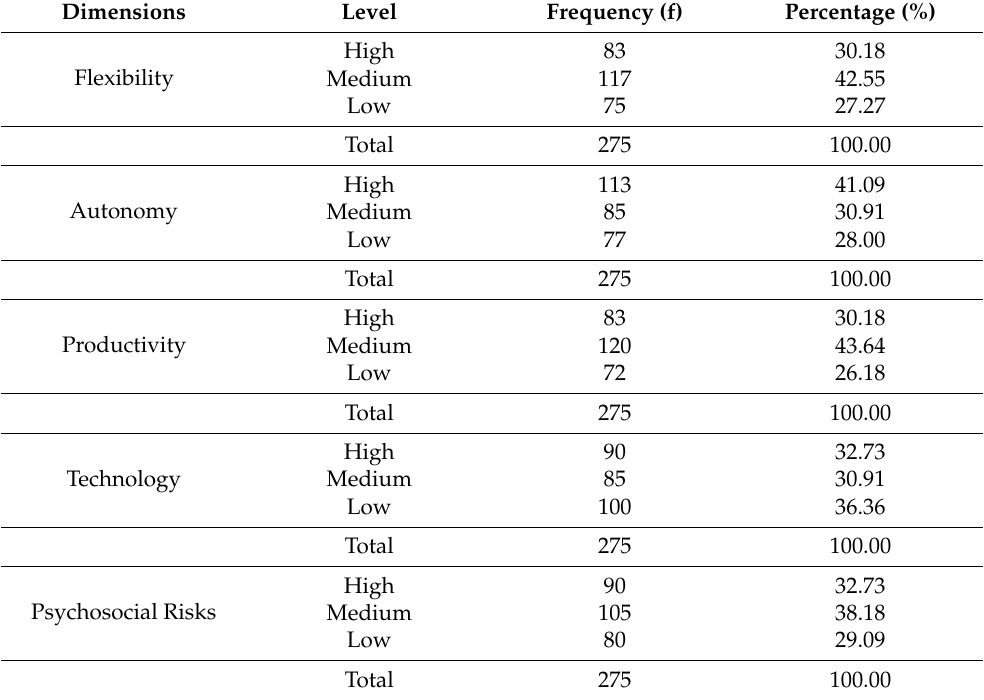
Table 19. Level of remote work dimensions in Peruvian workers during the COVID-19 pandemic. Dimensions Level Frequency (f) Percentage (%) High Flexibility